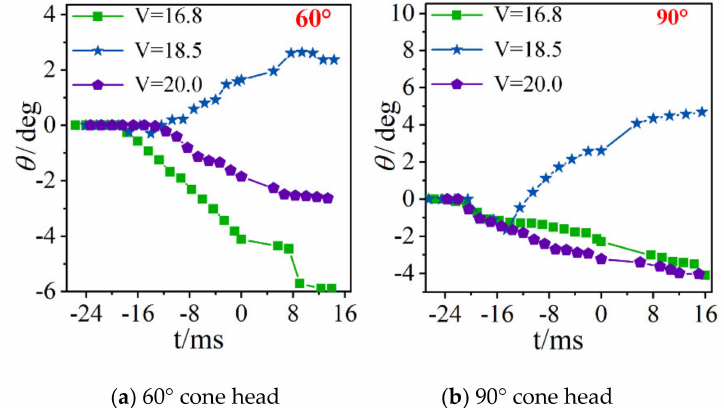
Figure 15. Variation curve of deflection angles of two head forms at three speeds. ( a ) 60 ◦ cone head ( b ) 90 ◦ cone